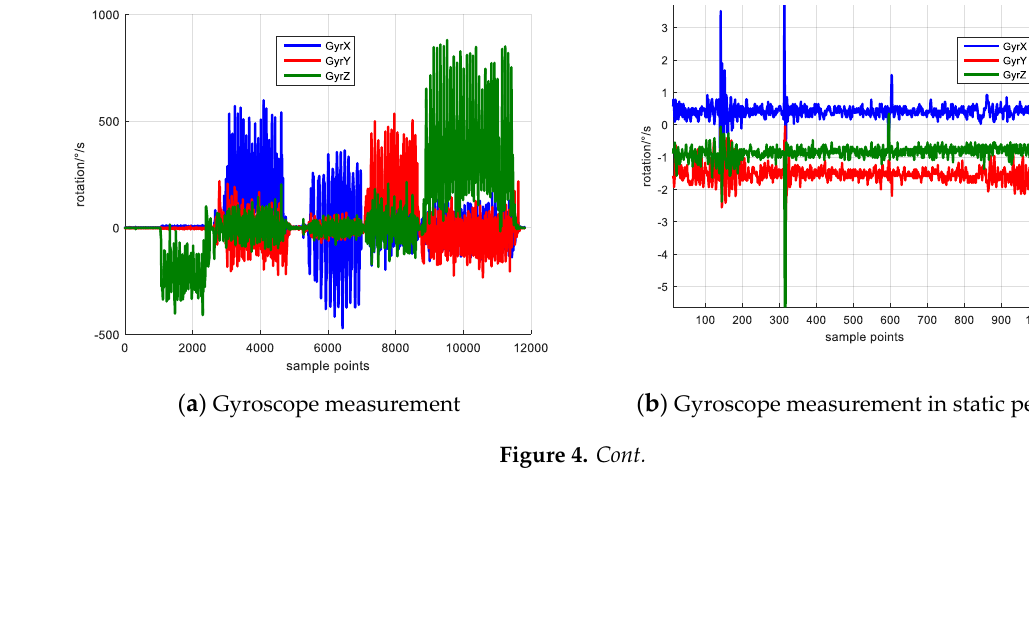
( b ) Non-Orthogonal Error Figure 5. Sensor Error